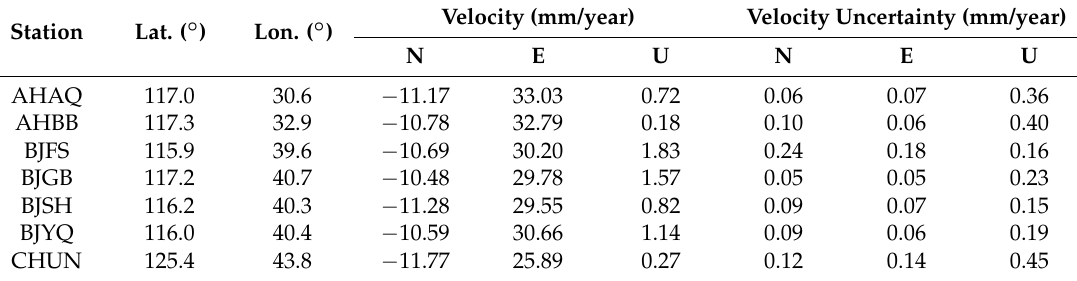
Three-dimensional velocity estimates and their uncertainties of the CMC